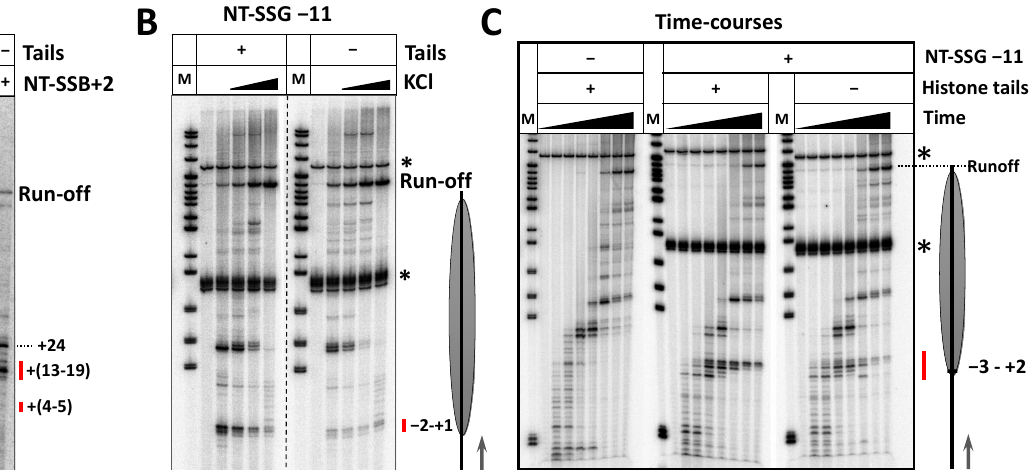
Figure 4. Removal of histone tails results in relief of nick- and gap-induced arrest of RNAP at +(1–5) and +(13–19) regions. ( A ) Nucleosomes NT-SSB+2 with and without histone tails were transcribed by E. coli RNAP for 2 min at 40 mM KCl. Analysis of pulse-labeled RNA by denaturing PAGE. M—pBR322 MspI digest. The regions of RNAP pausing/arrest affected by the presence of histone tails are indicated by red lines. ( B ) Nucleosomes with and without histone tails with NT-SSG at the po- sition −11 were transcribed by E. coli RNAP for 5 min at 40, 150, 300 or 1000 mM KCl. Analysis of pulse-labeled RNA by denaturing PAGE. M—pBR322 MspI digest. The asterisks indicate radioac- tively labeled fragments of the DNA template (103 and 273 nucleotides long). Position of the nucle- osome and direction of transcription are shown by the grey oval and arrow on the right, respec- tively. ( C ) Time courses of transcription through the nucleosomes (intact and with NT-SSG-11) with and without tails. The templates were transcribed by E. coli RNAP for 1 sec, 2 sec, 4 sec, 8 sec, 1 min, 5 min or 10 min at 150 mM KCl. Analysis of the pulse-labeled RNA by denaturing PAGE. M— pBR322 MspI digest. Radioactively labeled fragments of the DNA template (103 and 273 nucleotides in length) are shown by asterisks. Position of the nucleosome and direction of transcription are shown by the grey oval and arrow, respectively. The region of RNAP pausing near the position +1 in presence of ss-gap is indicated by the red line.